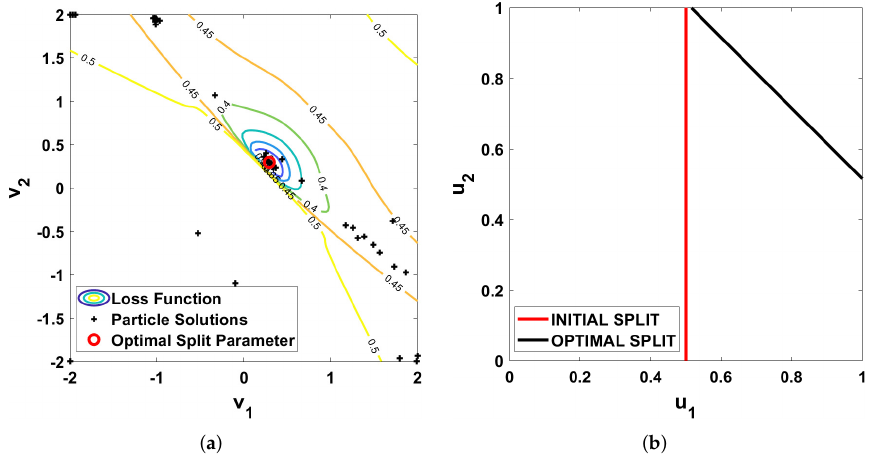
Figure 7. The loss function and model partition for NeO algorithm after iteration 1. ( a ) Loss function. ( b ) Model partition.